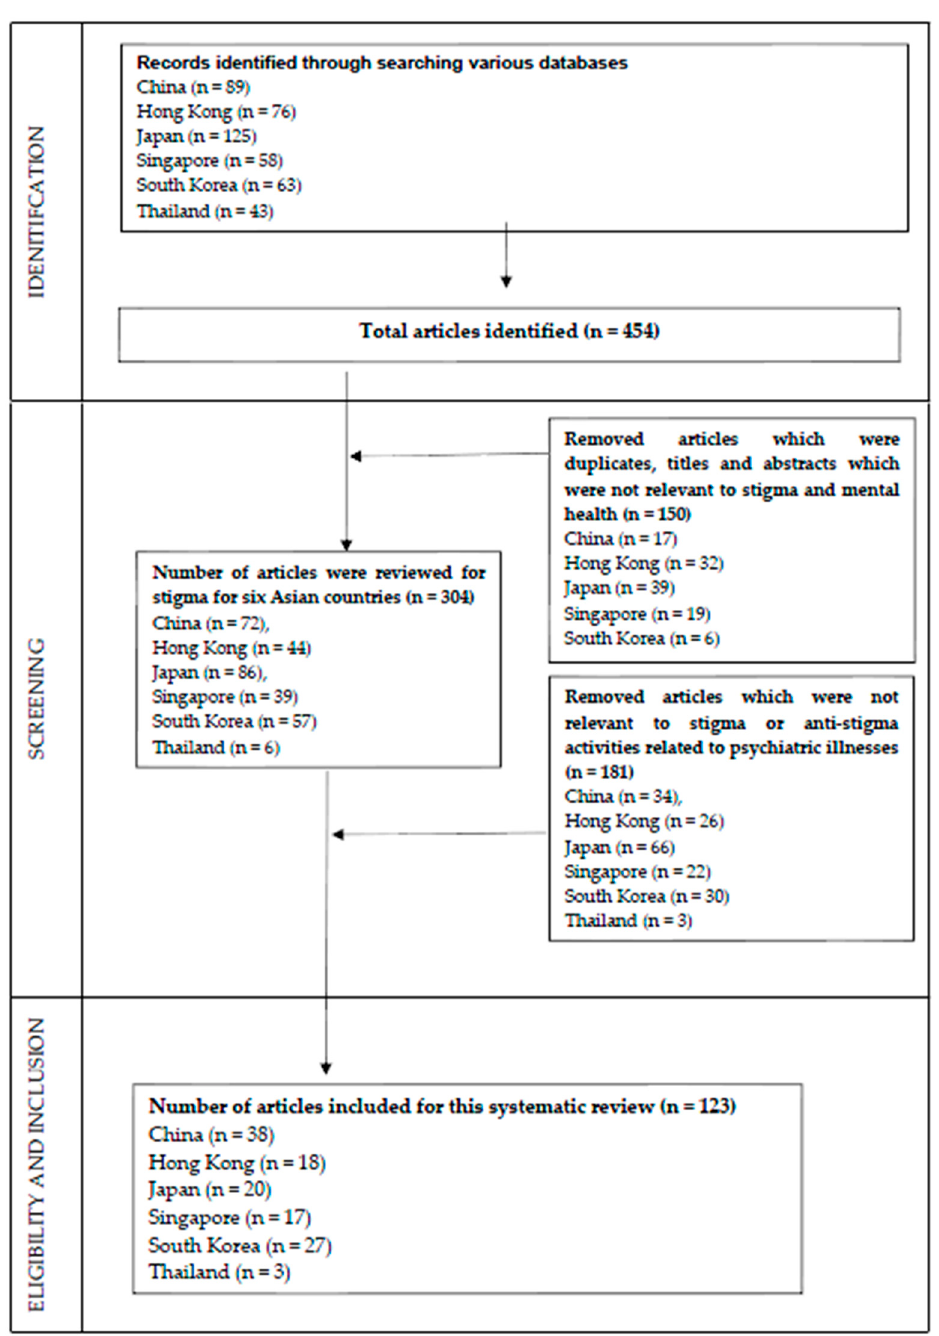
Figure 1. Full screening process in accordance to PRISMA guidelines.